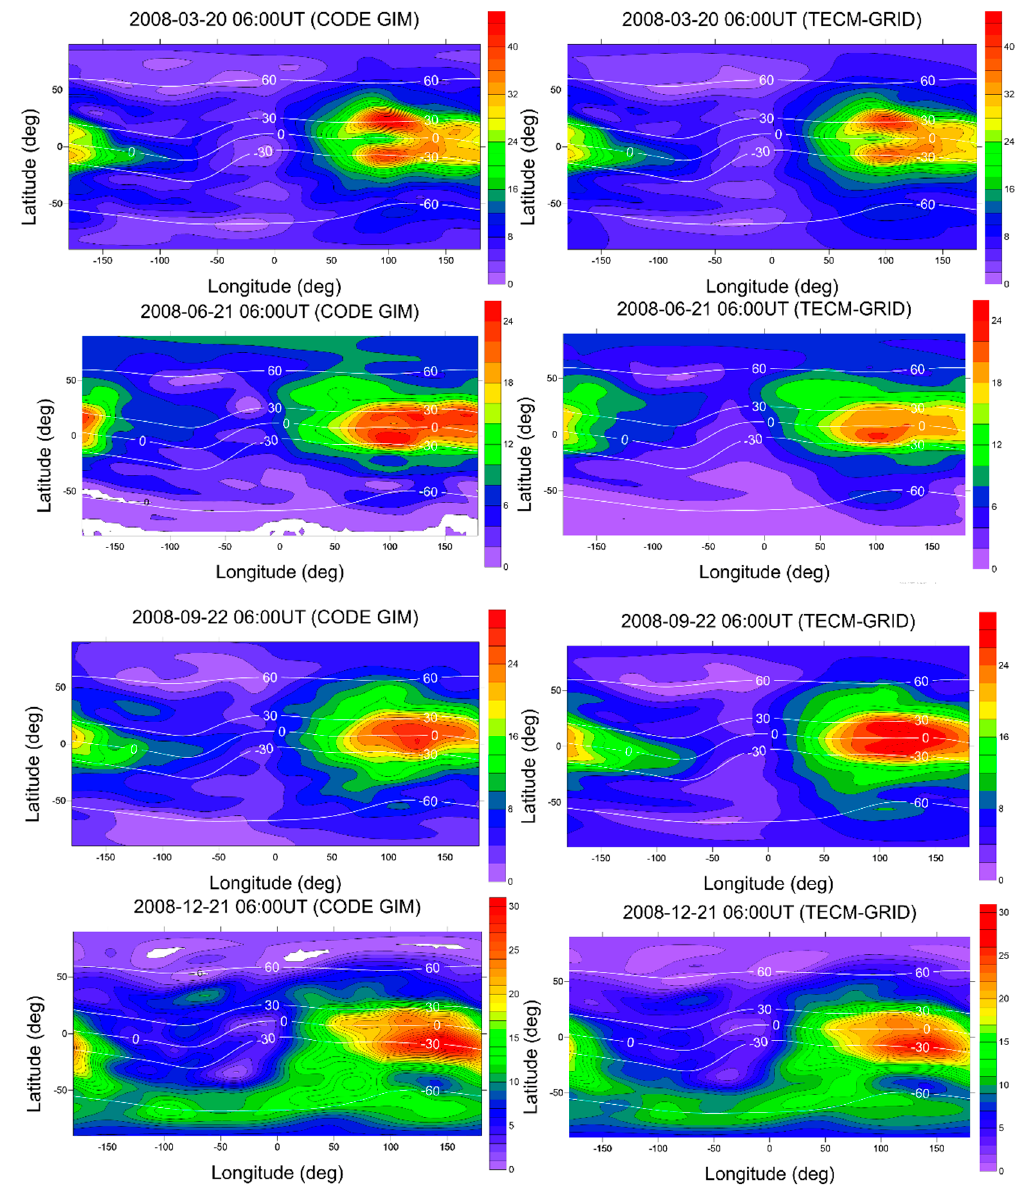
Figure 6. Comparison of CODE GIMs and TECM-GRID models (2008).